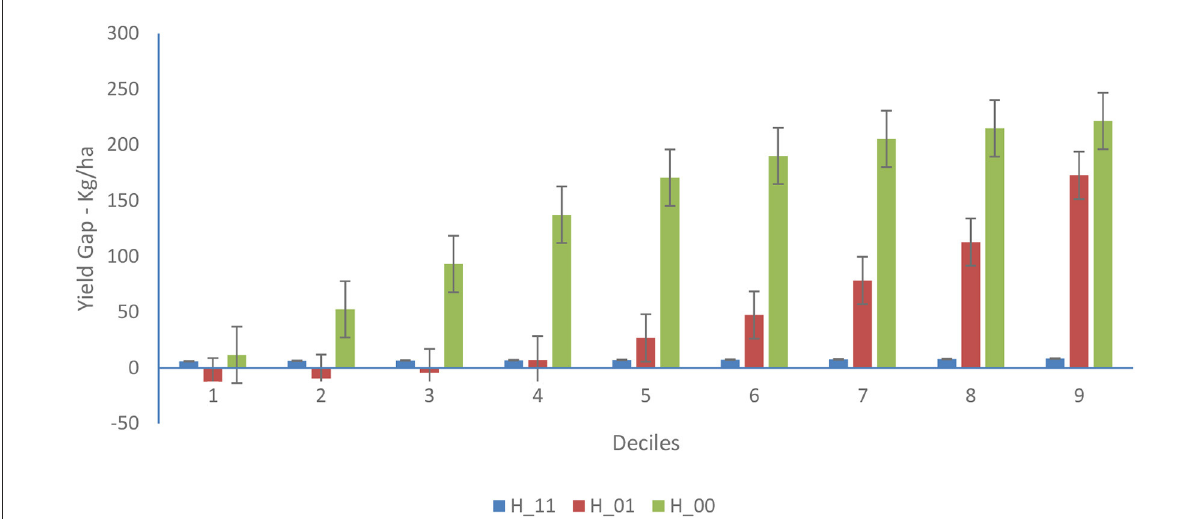
FIGURE2 Yield gap profile at the production technology frontier (Kg/Ha). Where H-11, H-00 and H-01 indicates mediated-adopters, non-mediated- non-adopters and mediated-non-adopters, respectively at the production technology frontier function of yield. The figure illustrates the yield gap profile in deciles of farmers operating at different production technology frontiers, compared to farmers at the best production frontier operating at zero technological inefficiency.